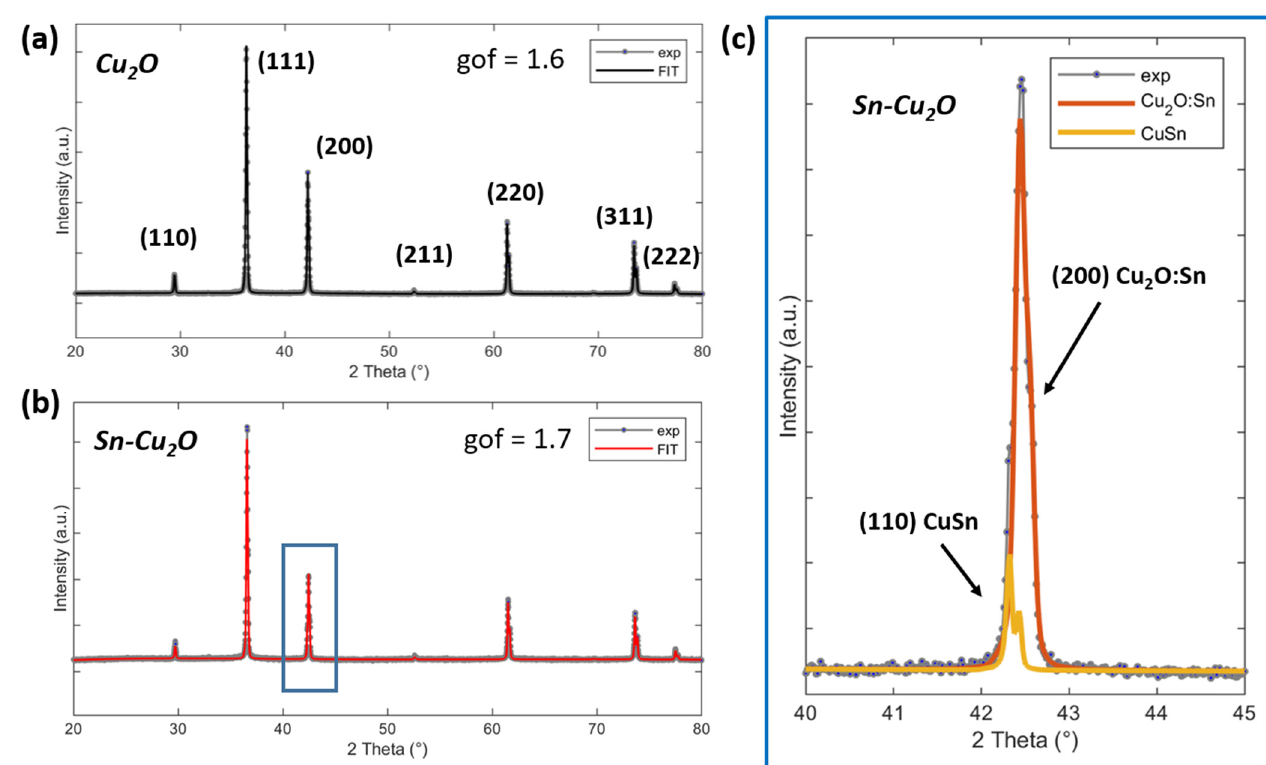
Figure 1. XRD patterns of Cu 2 O ( a ) and Sn-Cu 2 O ( b ) catalysts with corresponding Rietvled refinement fit and goodness-of-fit (gof) values. Panel ( c ) provides a view of the (200) peak of the XRD pattern from Sn-Cu 2 O sample, showing contributions from two different phases. Table 1. Parameters obtained from Rietveld refinement for the Cu 2 O and Sn-Cu 2 O